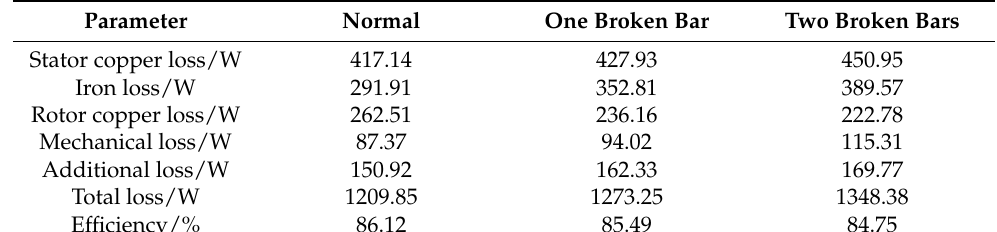
Table 4. Loss and efficiency of broken bars at different degrees.